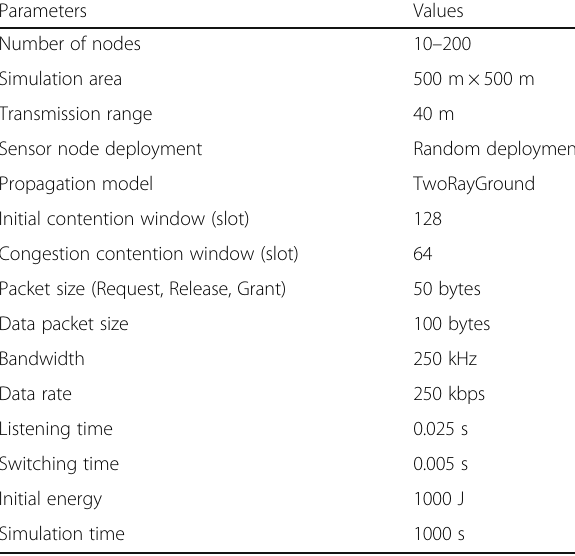
Table 2 CBR simulation